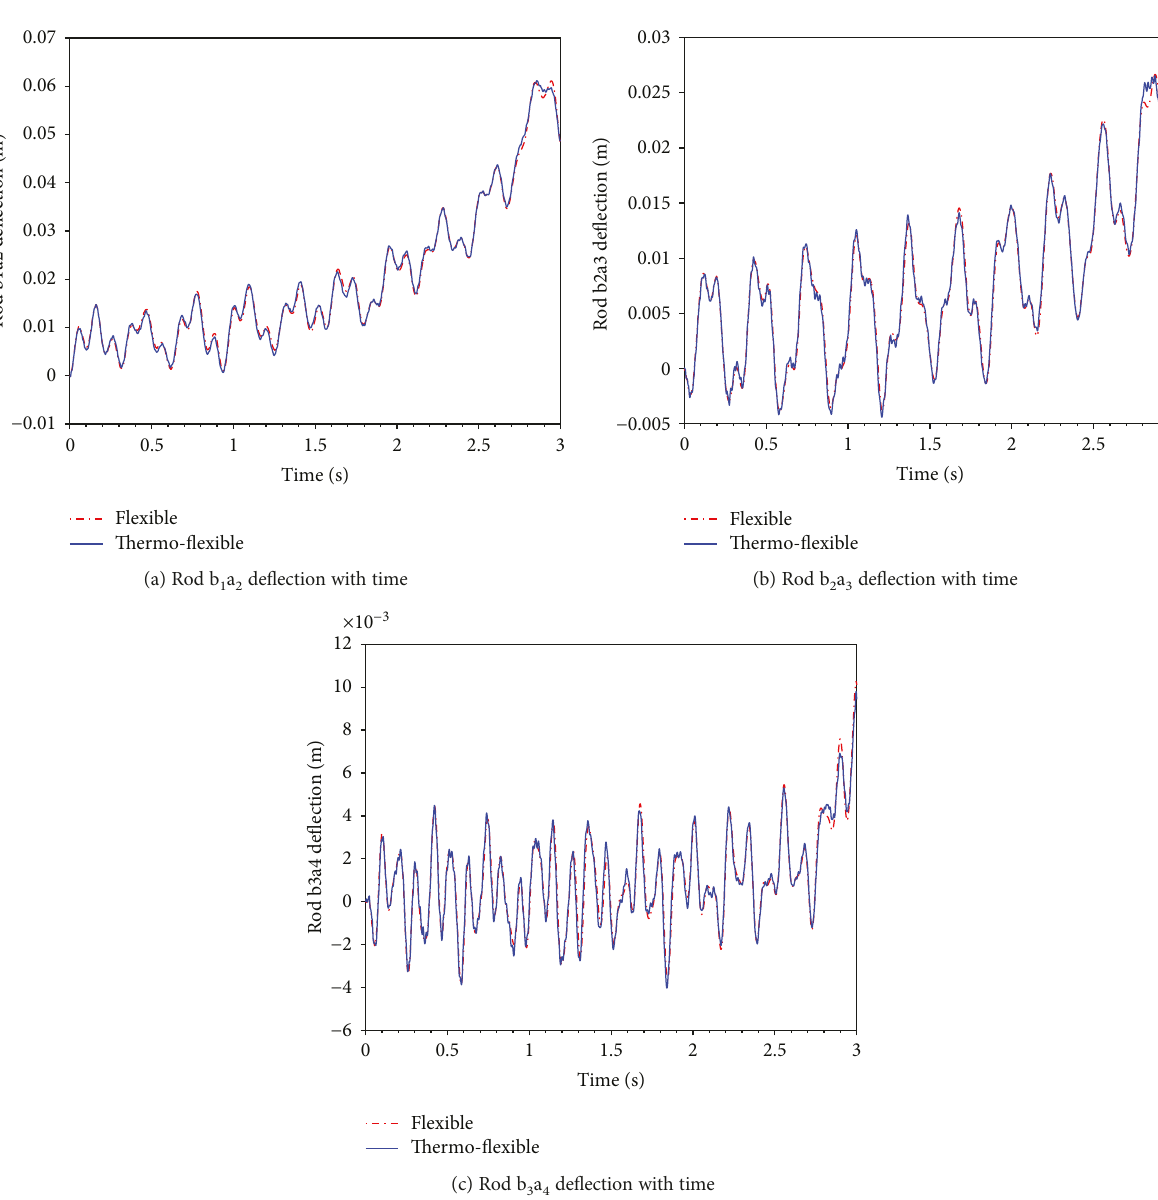
Figure 7: Temperature e ff ect on the de fl ection of